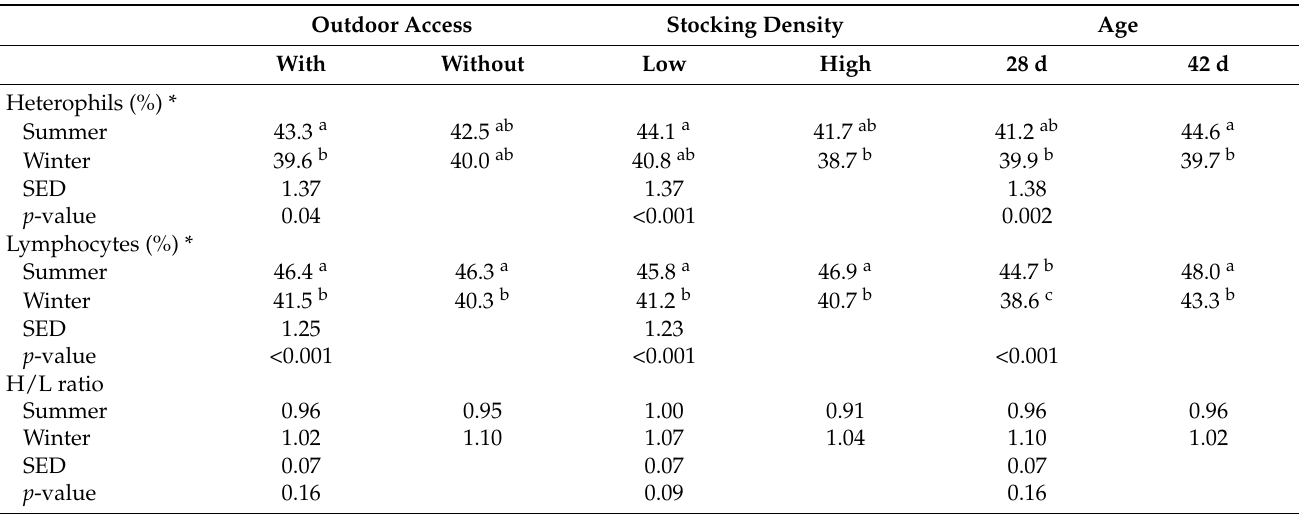
Table 7. Effects of season × system, season × density, and season × age interactions on the